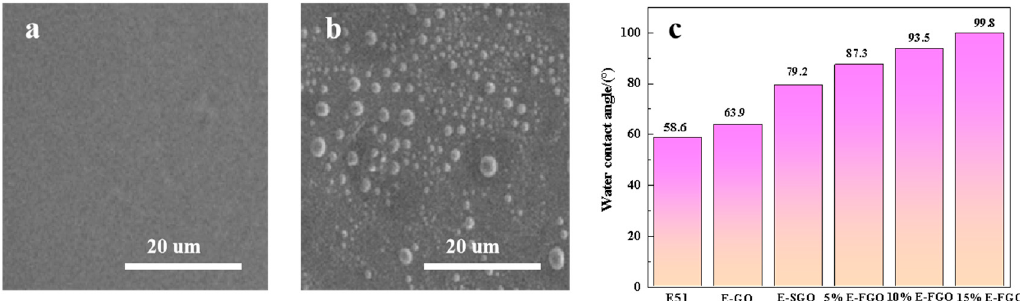
Figure 5. ( a , b ) FESEM plots of E-51 and 10% E-FGO composite tinting layers, respectively, and ( c